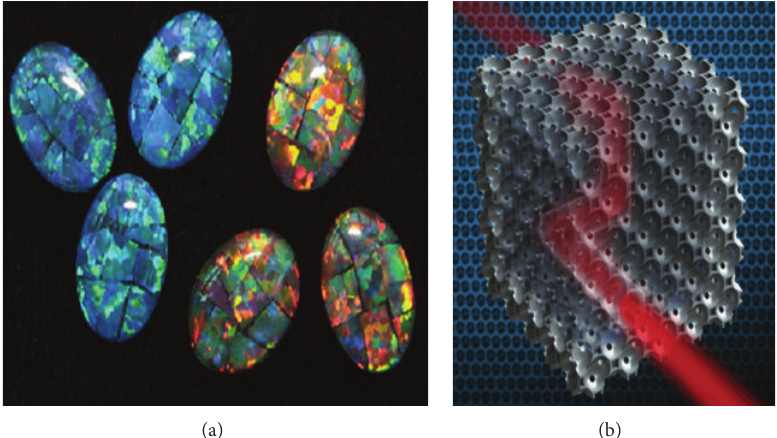
Figure 2: (a) Synthetic opal; (b) structure of a photonic crystal [4].